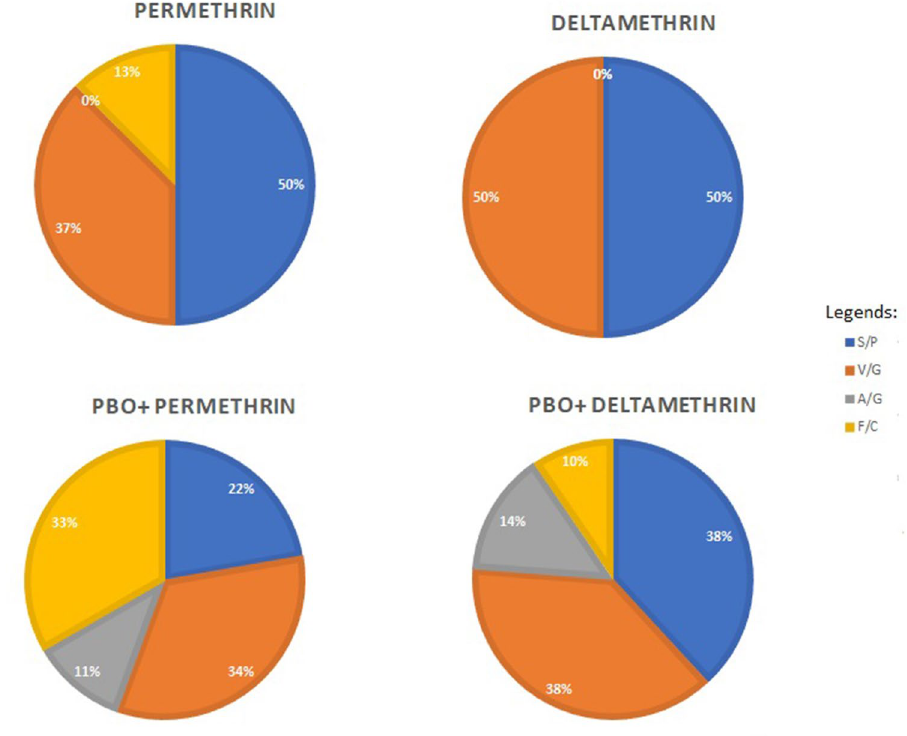
Figure 3. The resistance allelic frequency of Aedes aegypti Selangor strain identified with amino acid substitution in domain II and domain III of